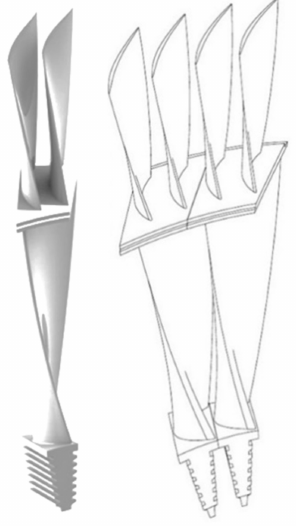
Figure 10. “Fork”-shape two-tier